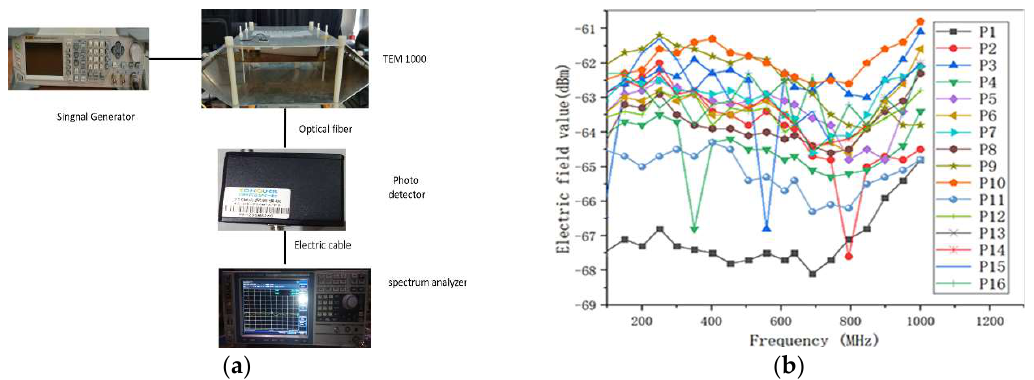
Figure 4. The test of the response characteristics of the sensors. ( a ) the test bench; ( b ) the response characteristics of the sensors.